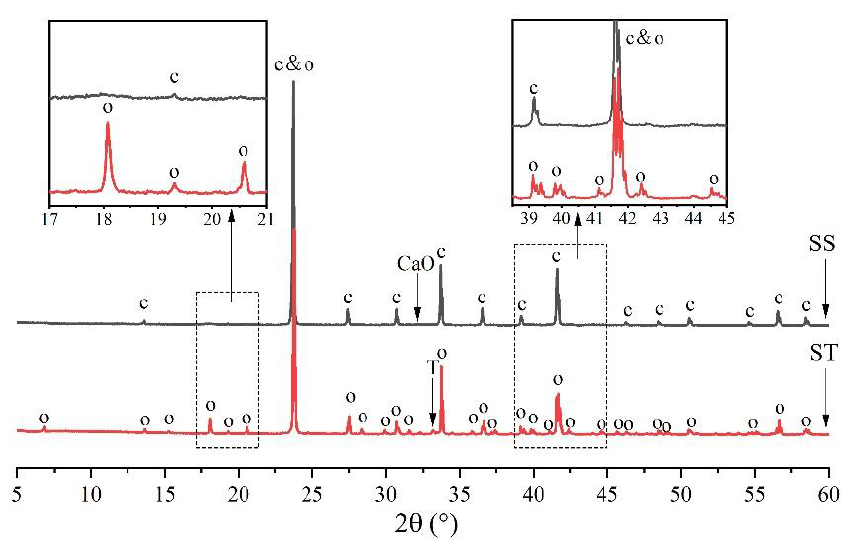
Figure 3. Comparison of XRD patterns of orthorhombic and cubic systems of ye’elimite.